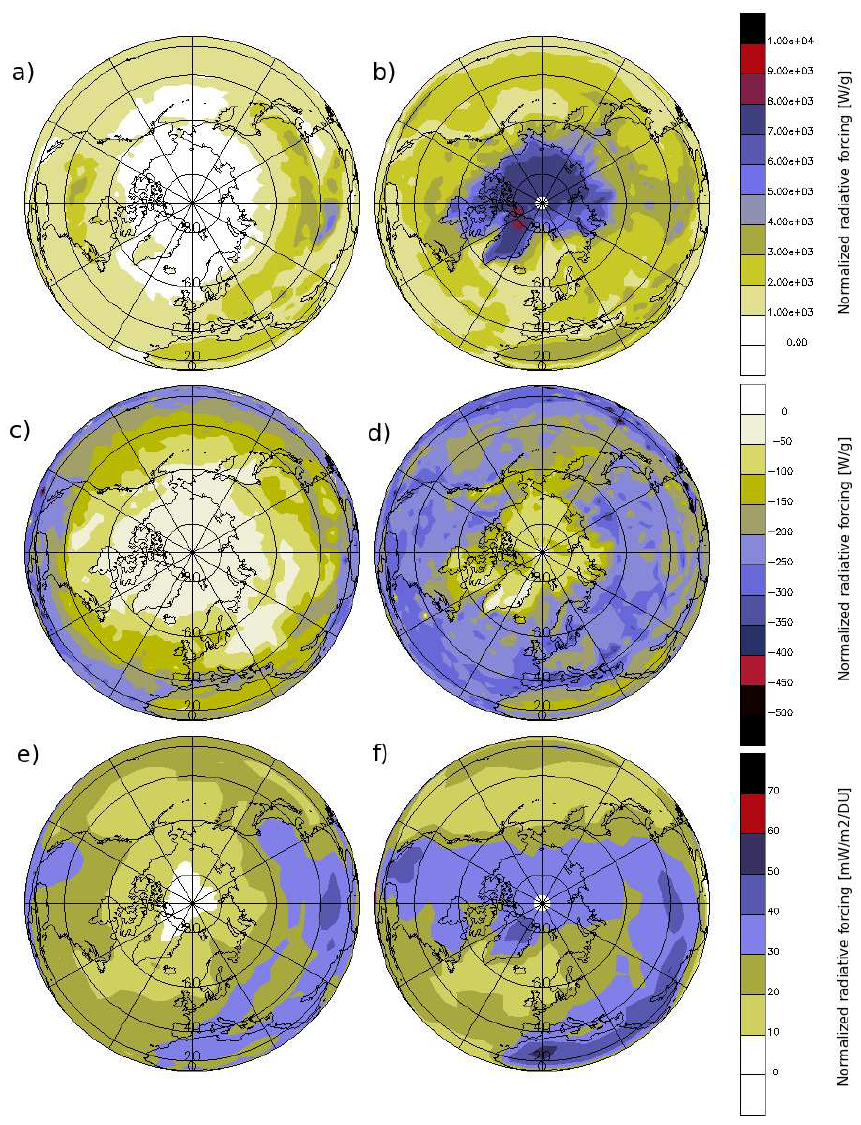
Fig. 9. Seasonal dependence of normalized radiative forcing for BC (a, b) , OC (c, d) and O 3 (e, f) from shipping emissions. Left hand panels show January–March when there is little sunlight in the Arctic region, right hand panels show April–June when sunlight is more prevalent.